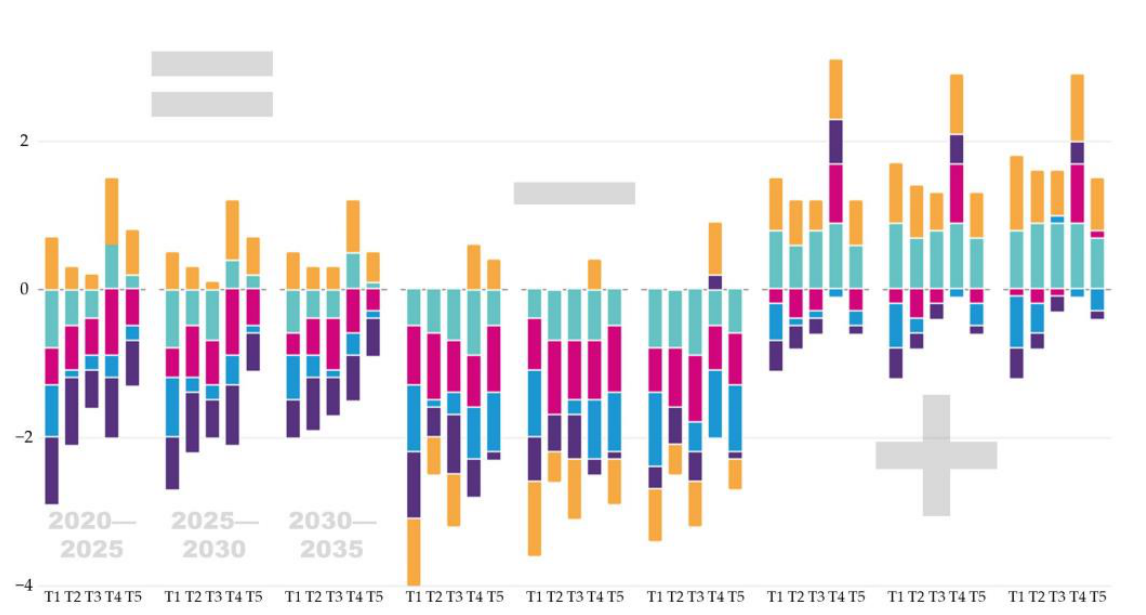
Figure 4. Influence of external challenges in scenarios over the time period of scenario forecasting